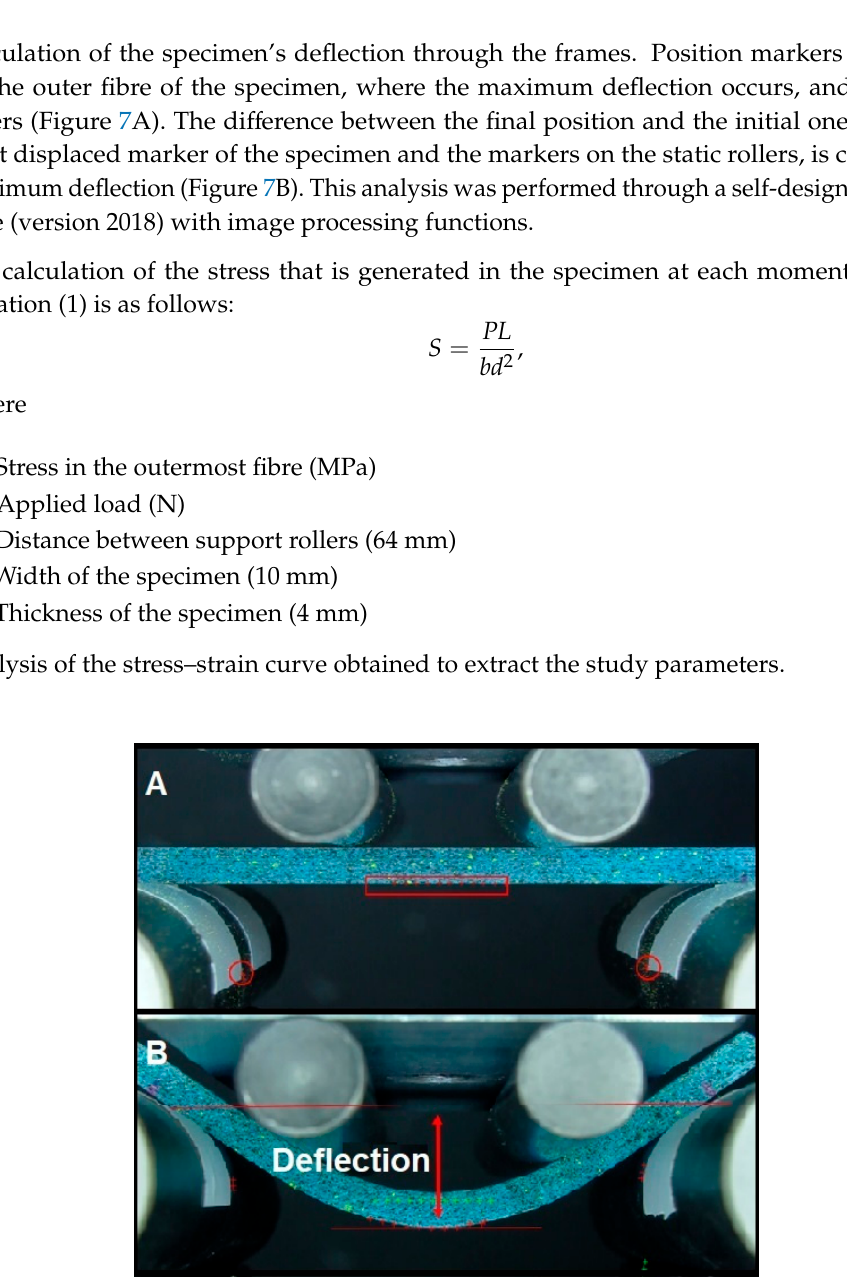
Figure 7. Schematic representation of the data collection process during the tests. ( A ) Initial position of markers; ( B ) final position (red crosses) and initial position (green crosses) of the markers.